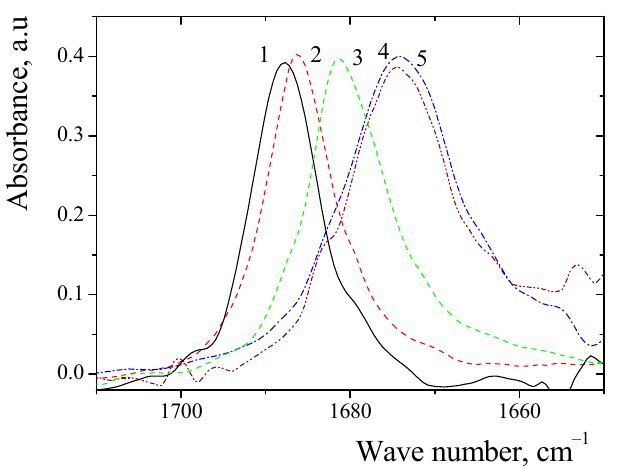
Figure 1. Diketopiperazines studied in this work. Scans of the spectra indicated their presence in the region from 400 to 4000 cm − 1 . The absorption frequencies of the C=O area was analyzed. The absorption frequencies of the C=O group of sarcosine anhydride in the environment of organic solvents are presented in Figure 2.